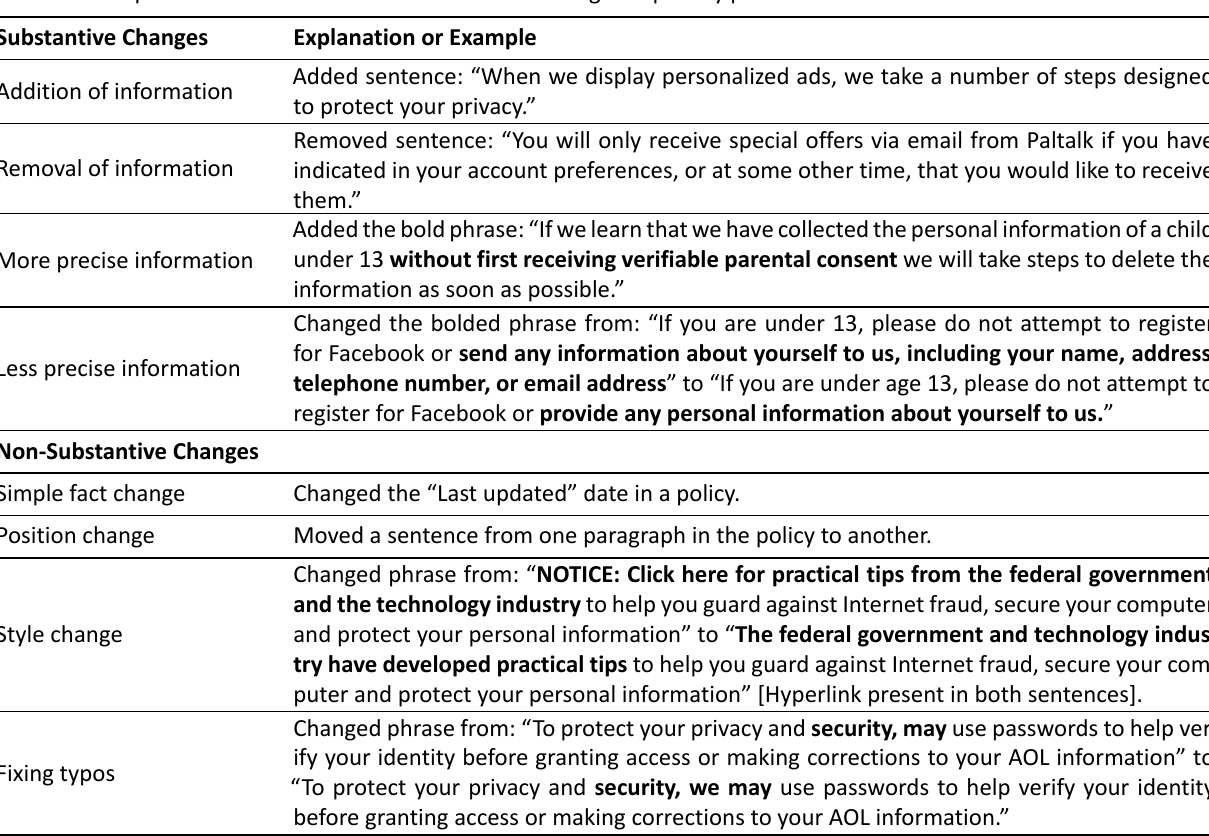
Table 2. Examples of substantive and non-substantive changes in privacy